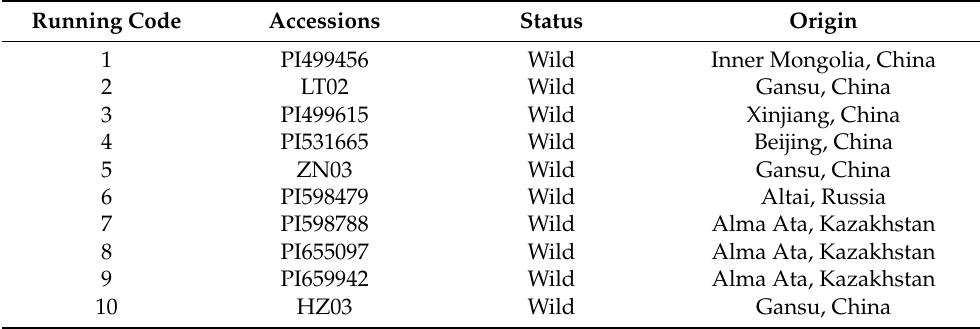
Table 1. Siberian Wildrye accessions used in the